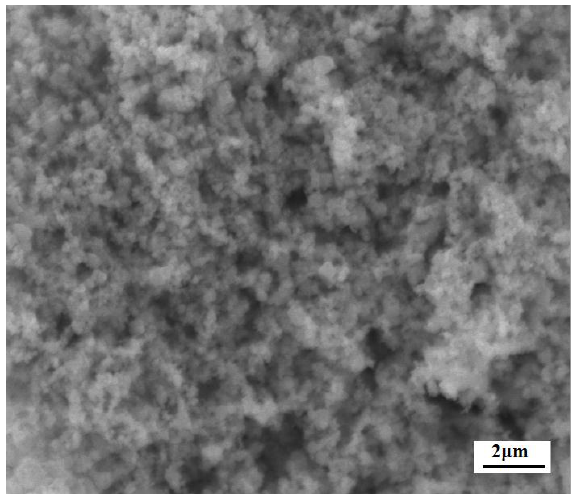
Figure 6. SEM image of the c-SnO 2 powders.